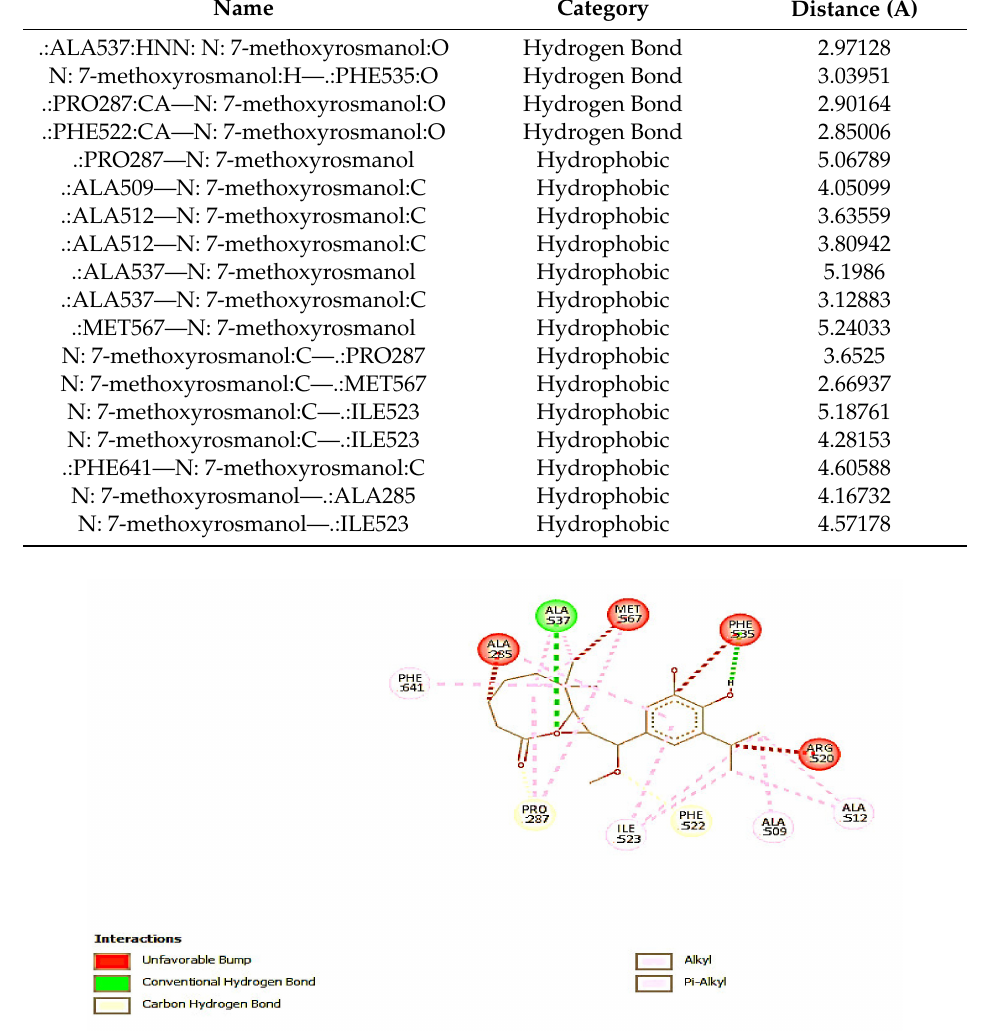
Figure 2. 2D interaction of 7-methoxyrosmanol with amino acid residues of